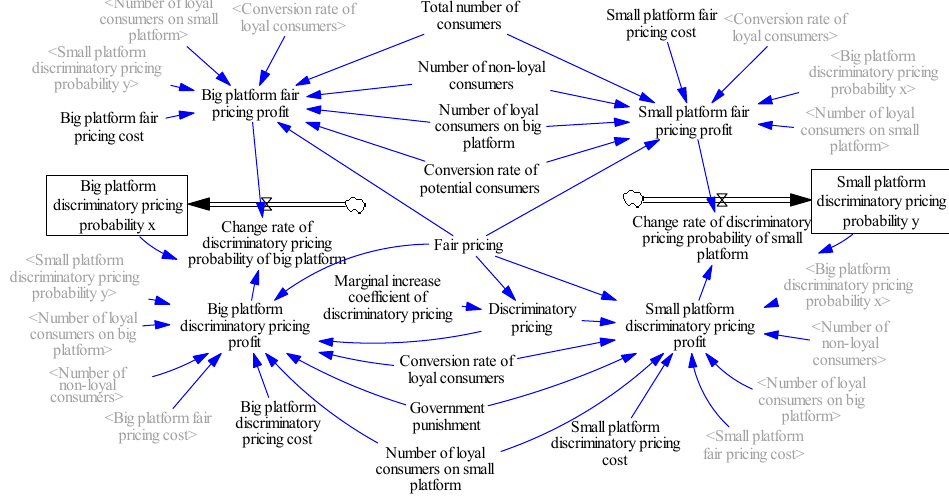
Figure 1. The System Dynamics model with the government supervision mechanism.